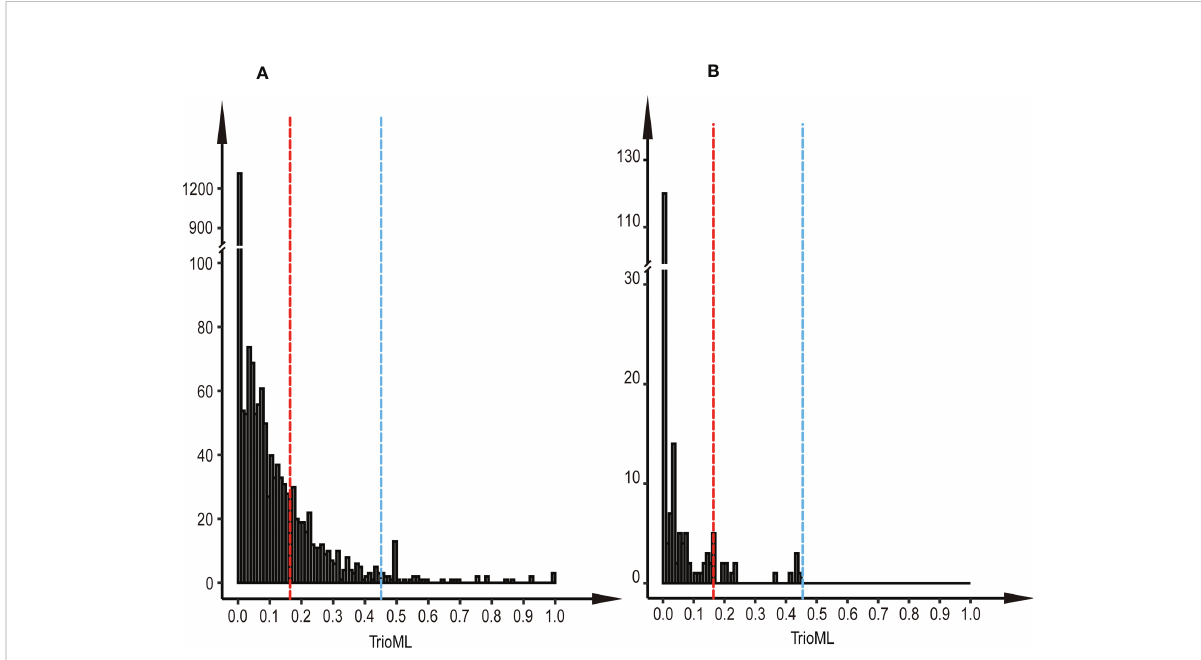
FIGURE 1 Histogram of paired TrioML values. (A) Histogram of paired TrioML values of parental clones in the third-generation seed orchard. (B) Histogram of paired TrioML values between parents with 191 cases of mating success. The red dotted line represents the unrelated cutoff of the parental clones (T = 0.1641), and the blue dotted line represents the threshold above which pairwise comparisons were considered fi rst-degree relatives (T =